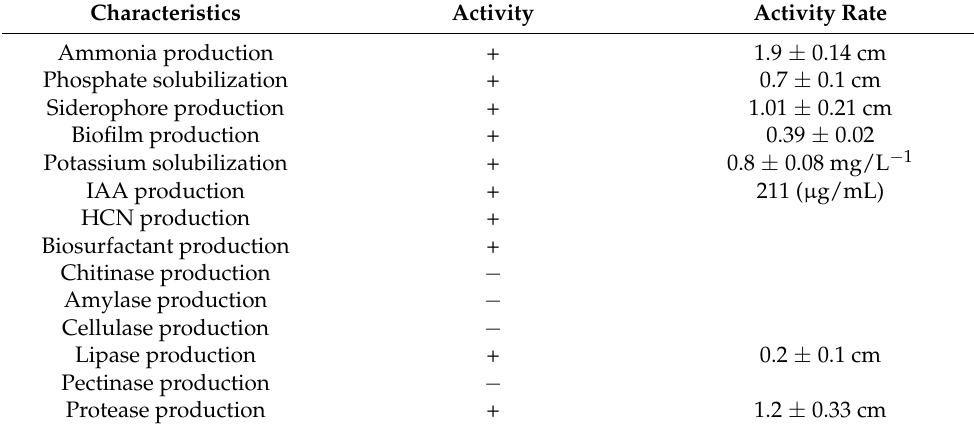
Table 2. Plant growth promotion factors and hydrolytic enzyme production by the endophytic FG106